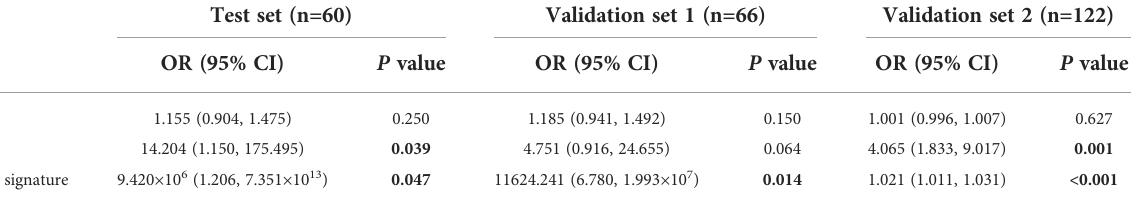
TABLE 4 Multivariate logistic regression analysis in the test and validation sets.